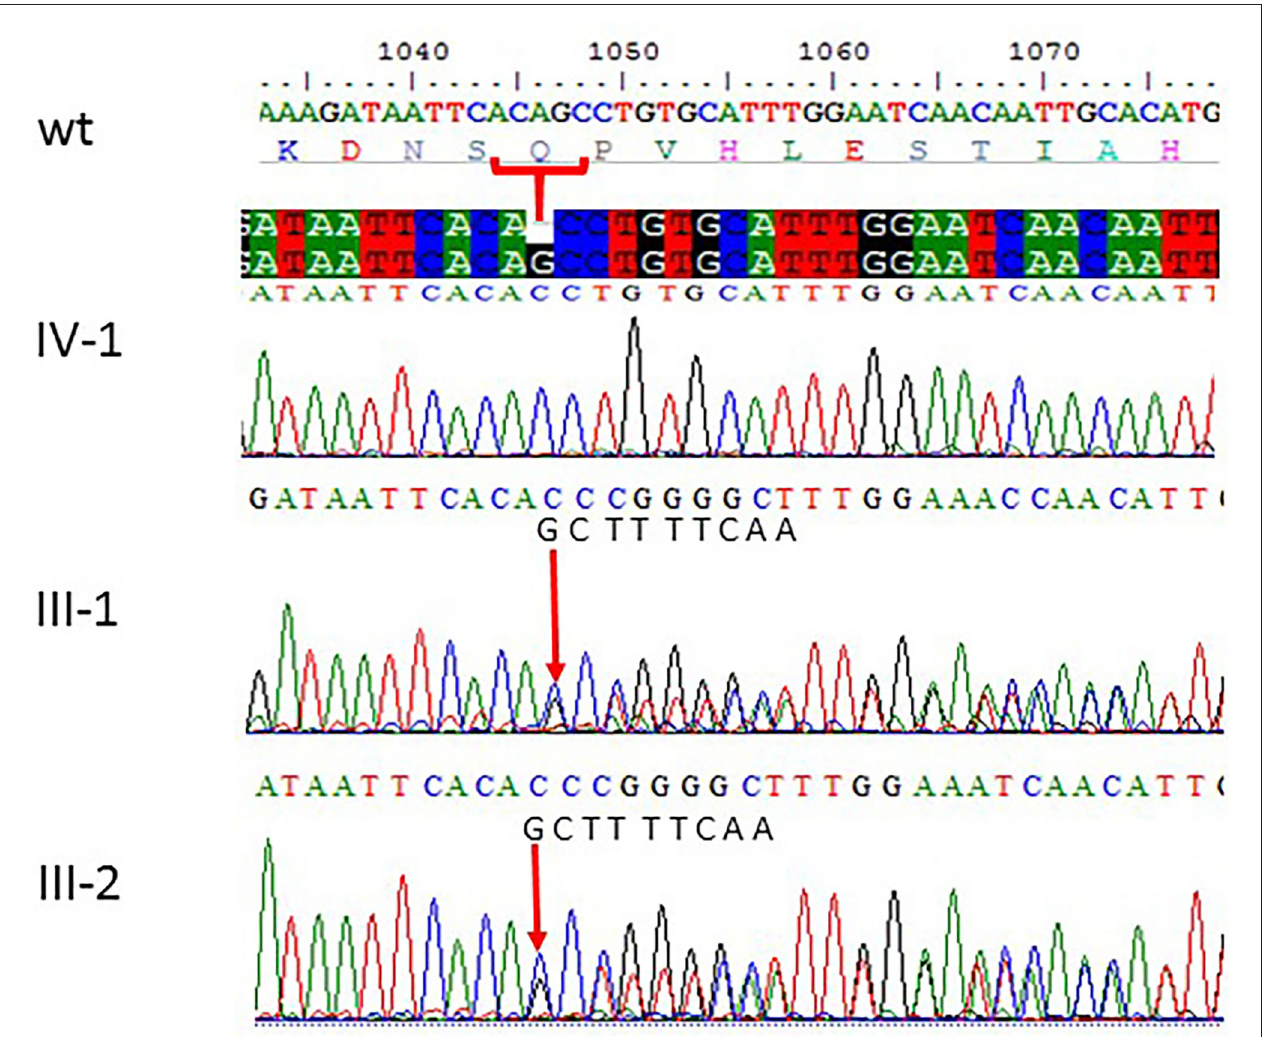
FIGURE 3 | Sanger sequencing chromatograms showing c.1047del G, p.Gln349HisfsTer18 in ASPM gene mutation in family 2. Proband IV-1 showed deletion of “G” bp as compared with the wild-type control, while both parents III-1 and III-2 are heterozygous at this position. The wild-type normal sequence “GCTTTTCAA” was also added to show change in frameshift after mutation. The upper panel shows the sequencing of the affected member, whereas the lower panel shows the parents who are carrier individuals; the arrow is pointing at the site of